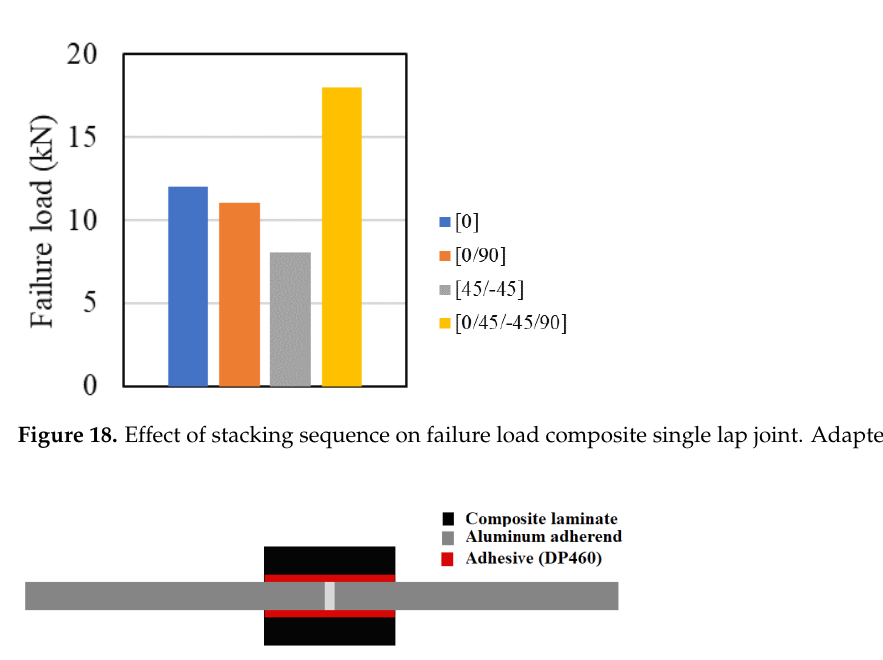
Figure 19. Double strapped composite joint as studied by Akpinar [138].